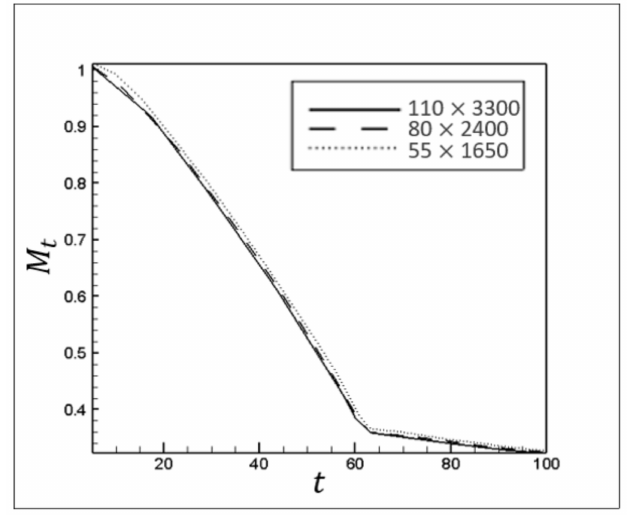
Figure 5. The effects of changes in the lattice layout on changes in M t at different times.